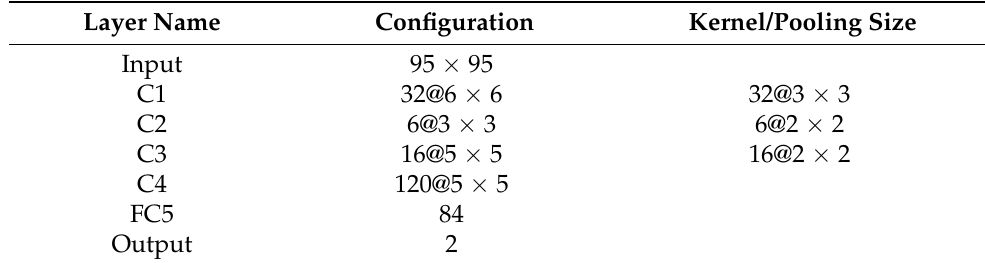
Table 4. The detailed structure of improved CNN1 model.